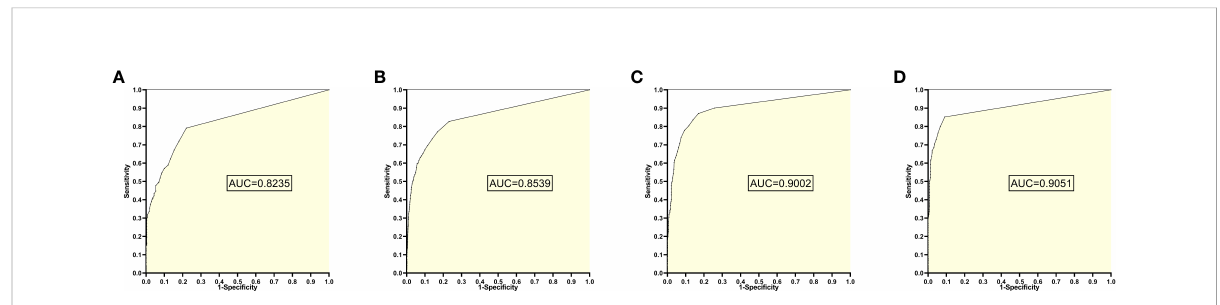
FIGURE 7 ROC curves and AUC values obtained from the training set 6 model testing each test set: (A) results from test set 1; (B) results from test set 2; (C) results from test set 3; (D) results from test set 4.